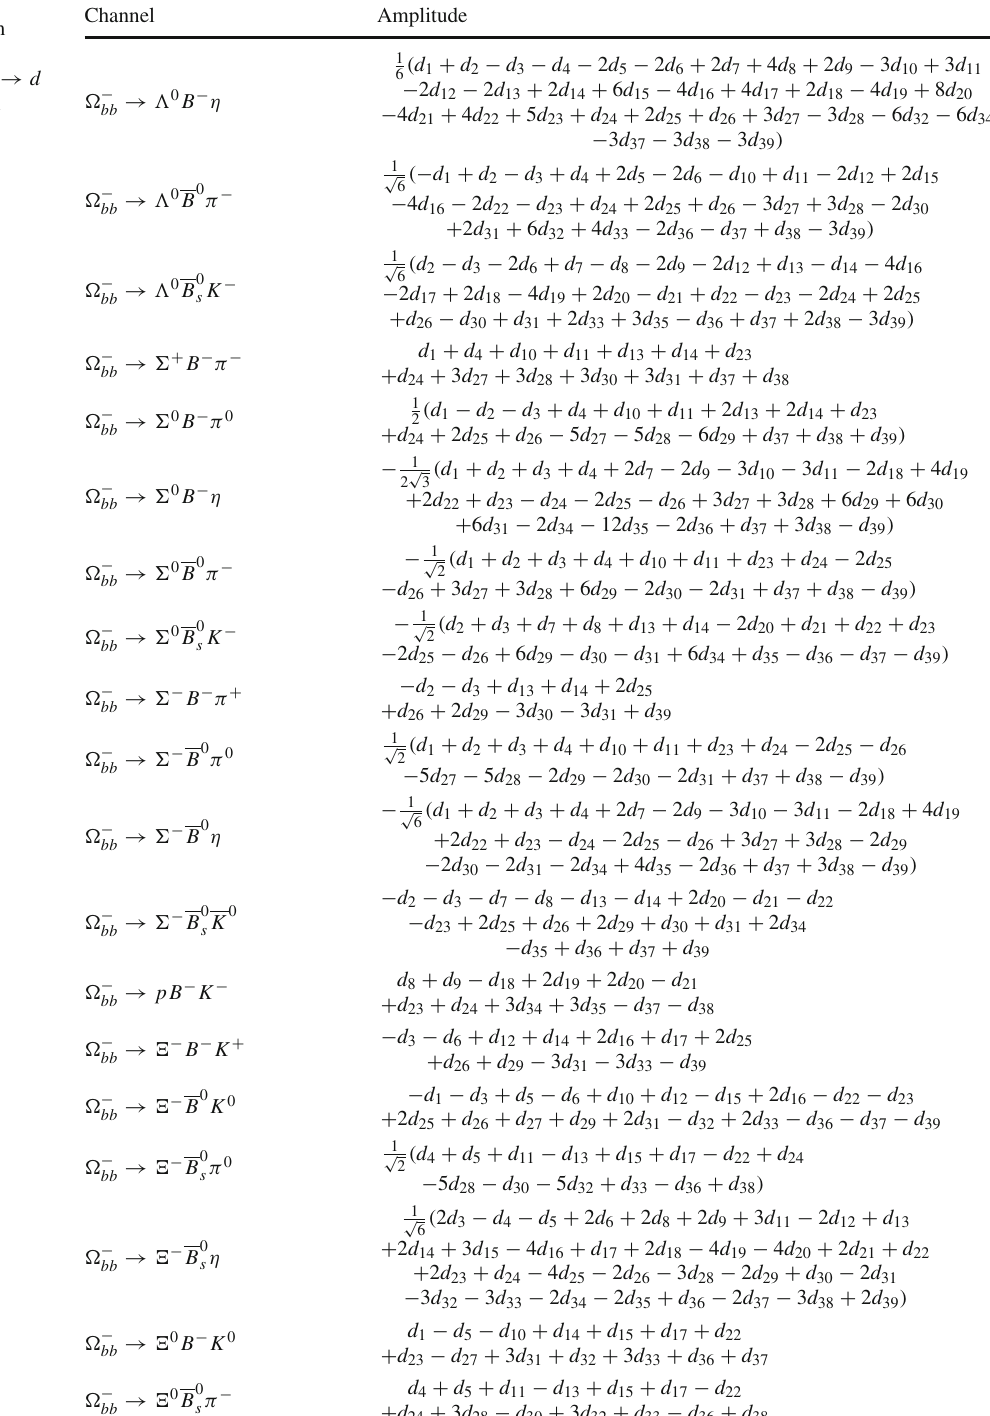
Table 29 Doubly bottom baryon decays into a bottom meson, a light baryon(8) induced by the charmless b → d transition and a light